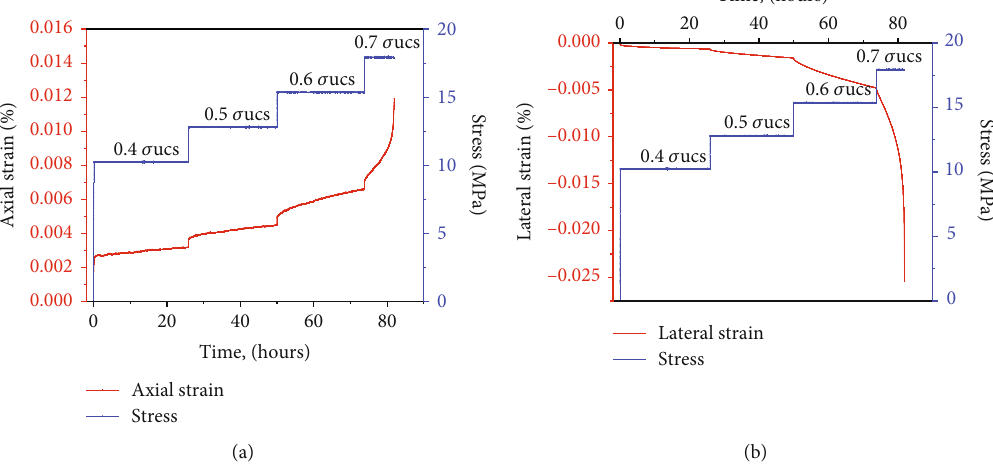
Figure 5: Creep testing curves under di ff erent stress levels.